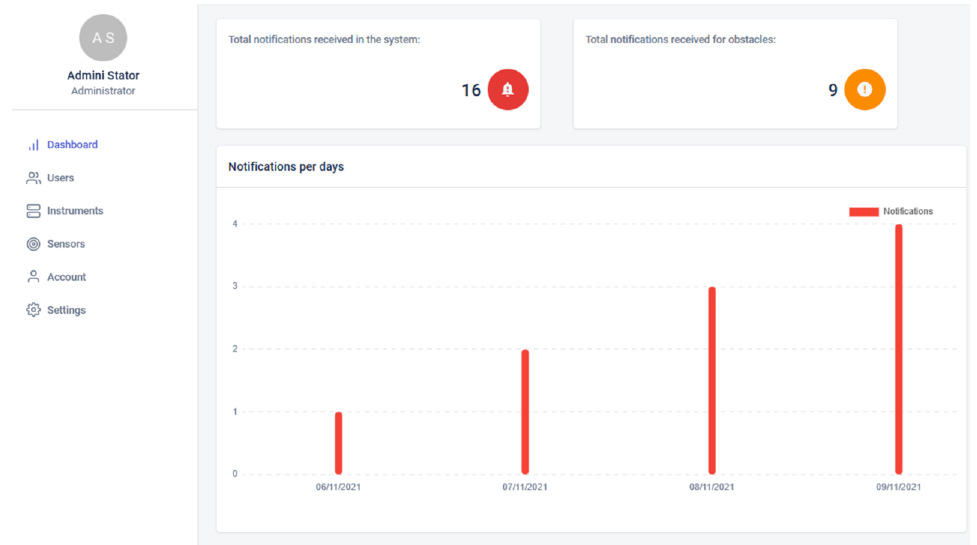
Figure 13. Statistical information shown in the Front-end application.